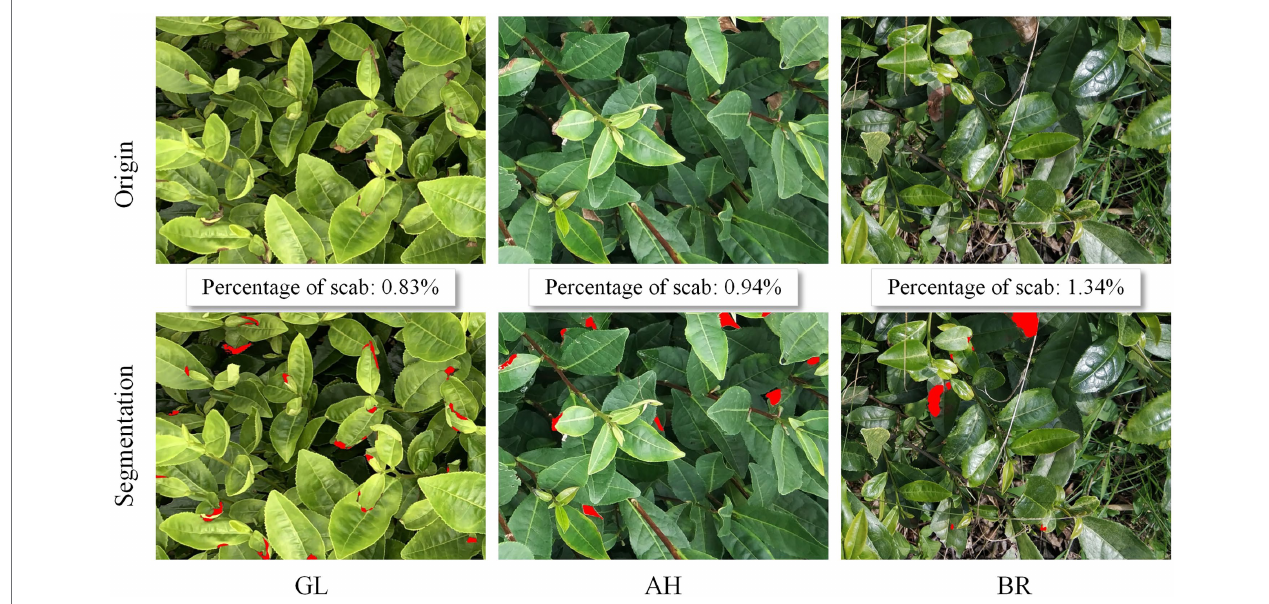
FIGURE 11 | The illustration of tea plant stress segmentation at canopy scale.